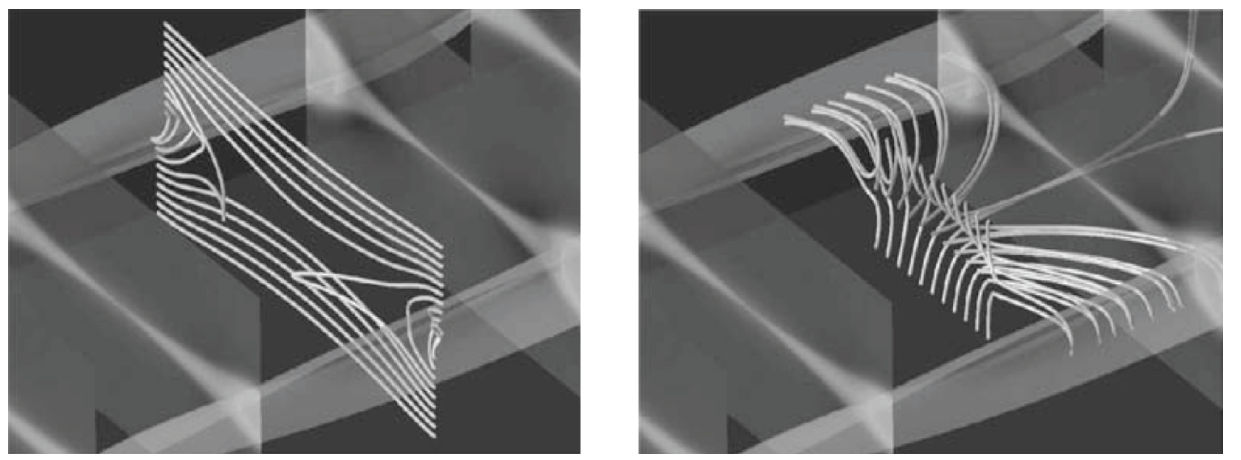
Figure 19. VooDoo simulation of Hall MHD reconnection. Left: Magnetic field streamlines at z = 0. Right: Flow velocity streamlines, at the same time and